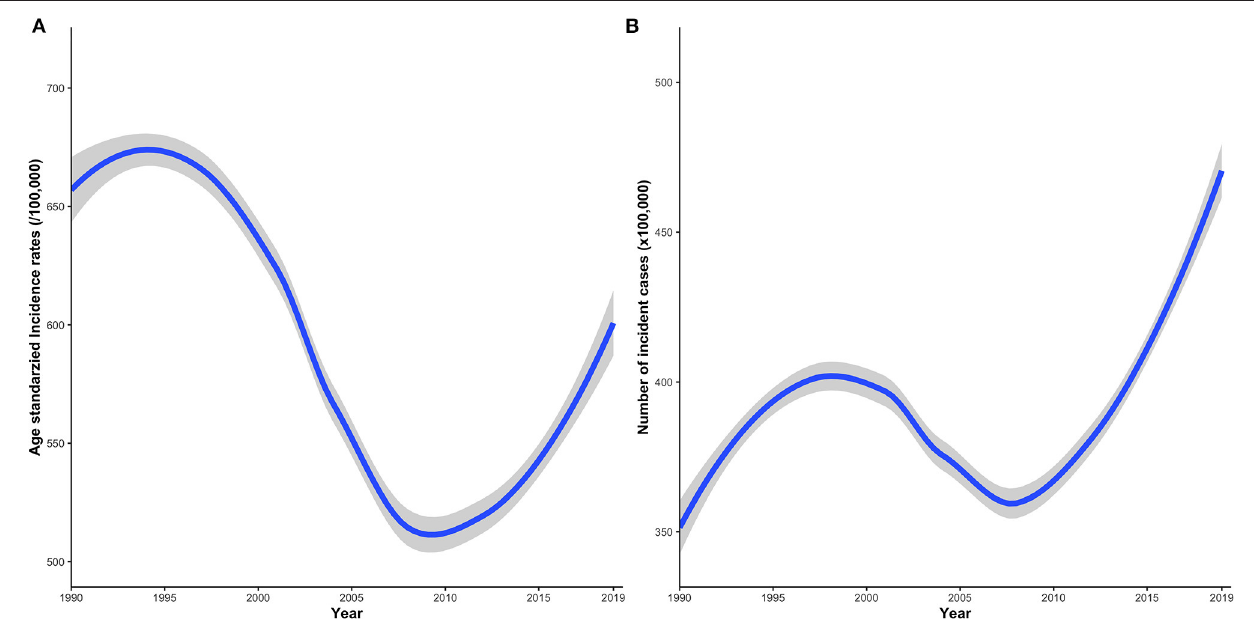
FIGURE 1 | Time trends of the global disease incidence of IOFBs from 1990 to 2019. (A) IOFBs burden in terms of ASIR per 100,000 persons; (B) IOFBs burden in terms of the number of incident cases × 100,000 persons. IOFBs, intraocular foreign bodies; ASIR, age-standardized incidence rate.